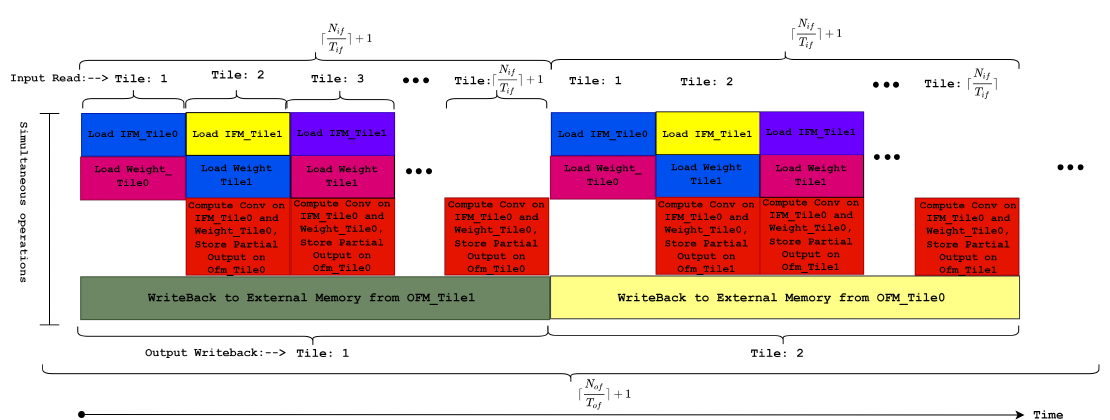
Figure 7. Illustration of double-buffering